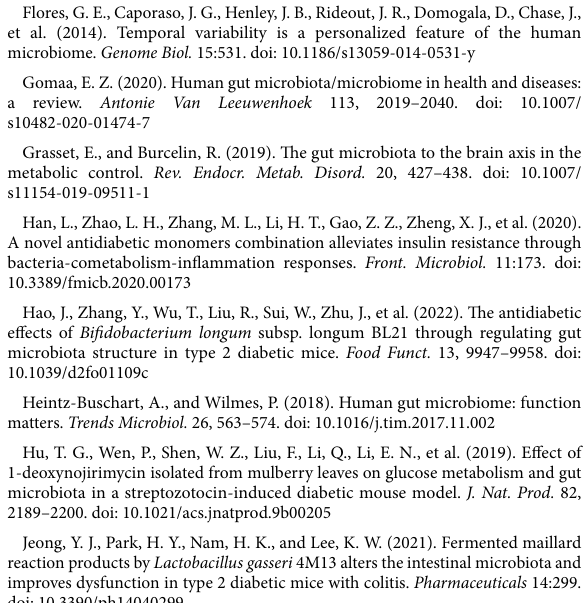
10.3389/fmicb.2022.1050352